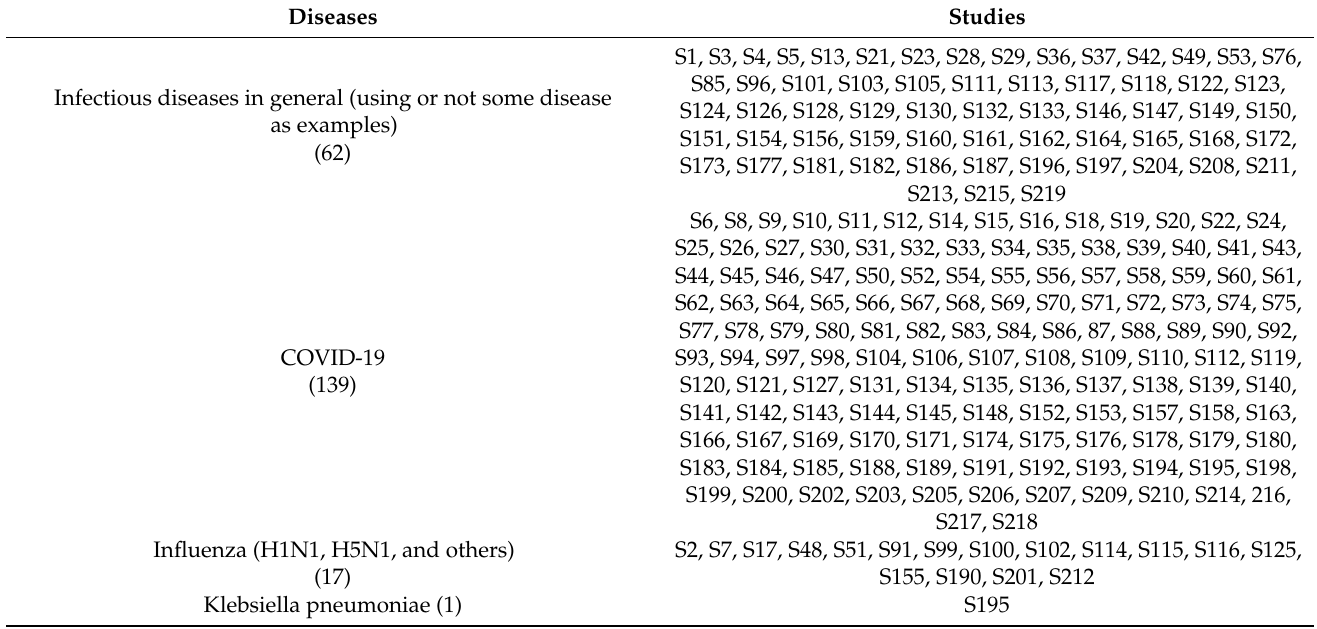
Table 10. Papers distribution according to the studied